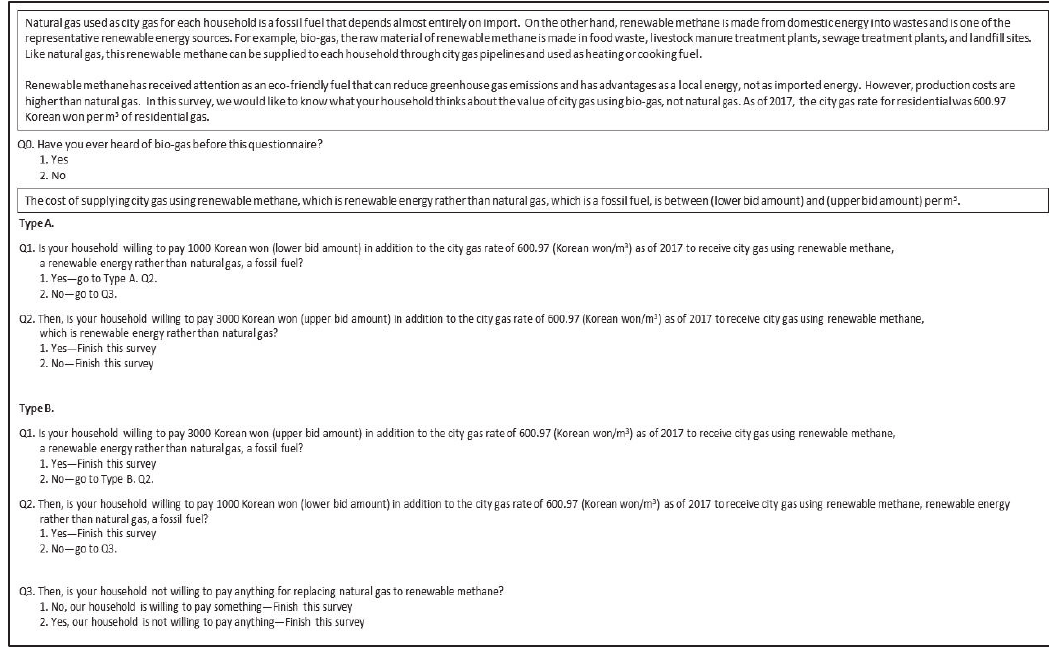
Figure A1. Main part of survey questionnaire used in this study.